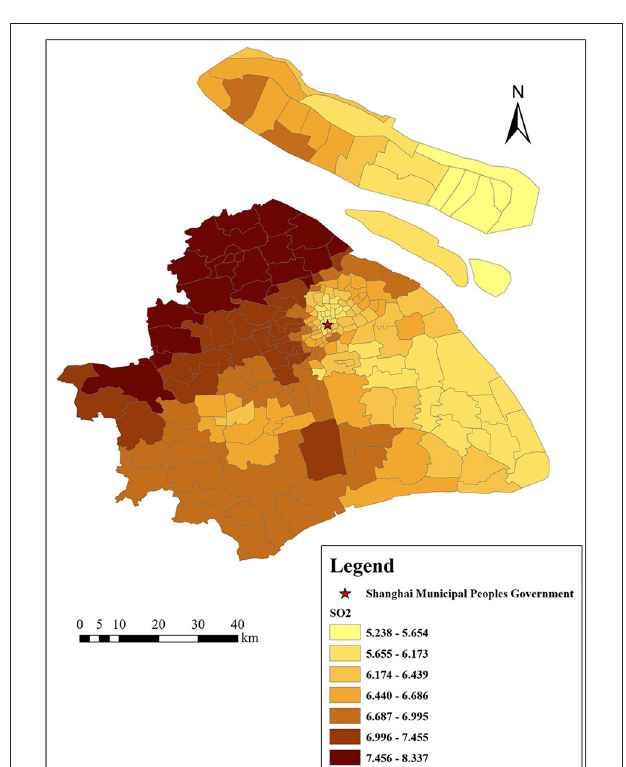
FIGURE 3 | Distribution of SO 2 ( µ g/m 3 ) in Shanghai.